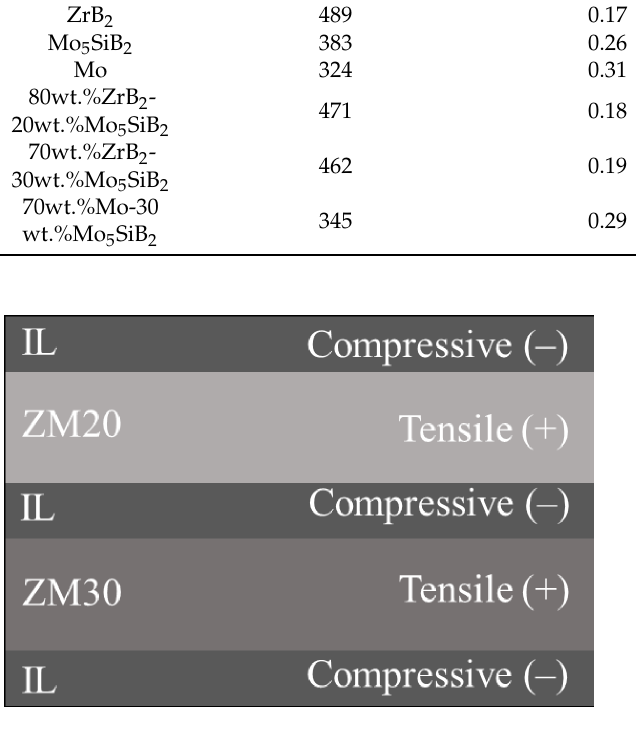
Figure 8. Diagram of the residual stresses applied to various layers in laminated ceramics. Table 2. Elastic modulus, Poisson’s ratio, and CTEs of raw materials and the laminated ceramics.